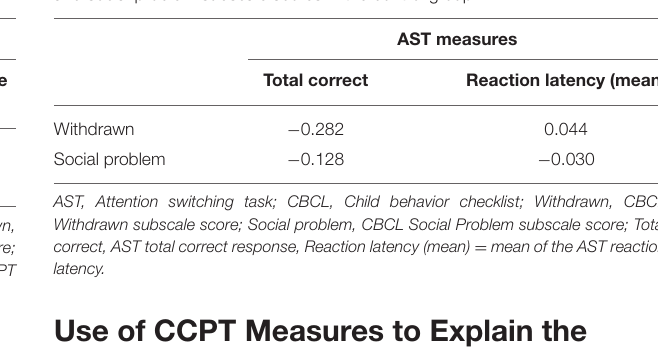
TABLE 7 | Correlation coefficients of the AST measures with the CBCL withdrawn and social problem subscale scores in the control